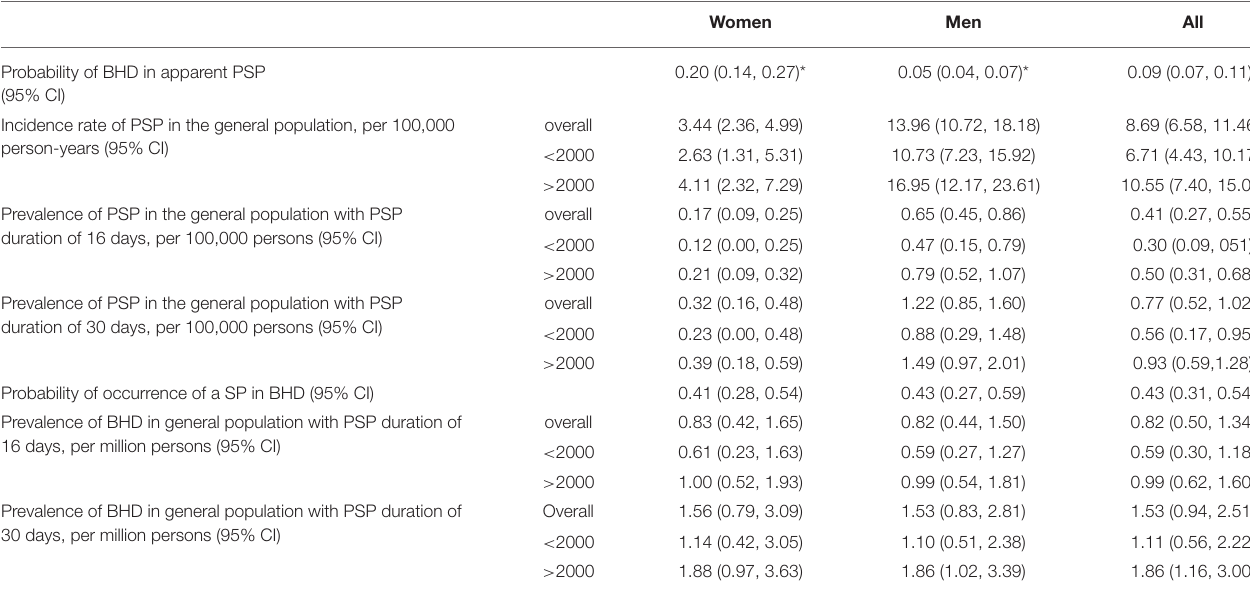
TABLE 2 | Bayes equation’s components estimated by random-effects models.